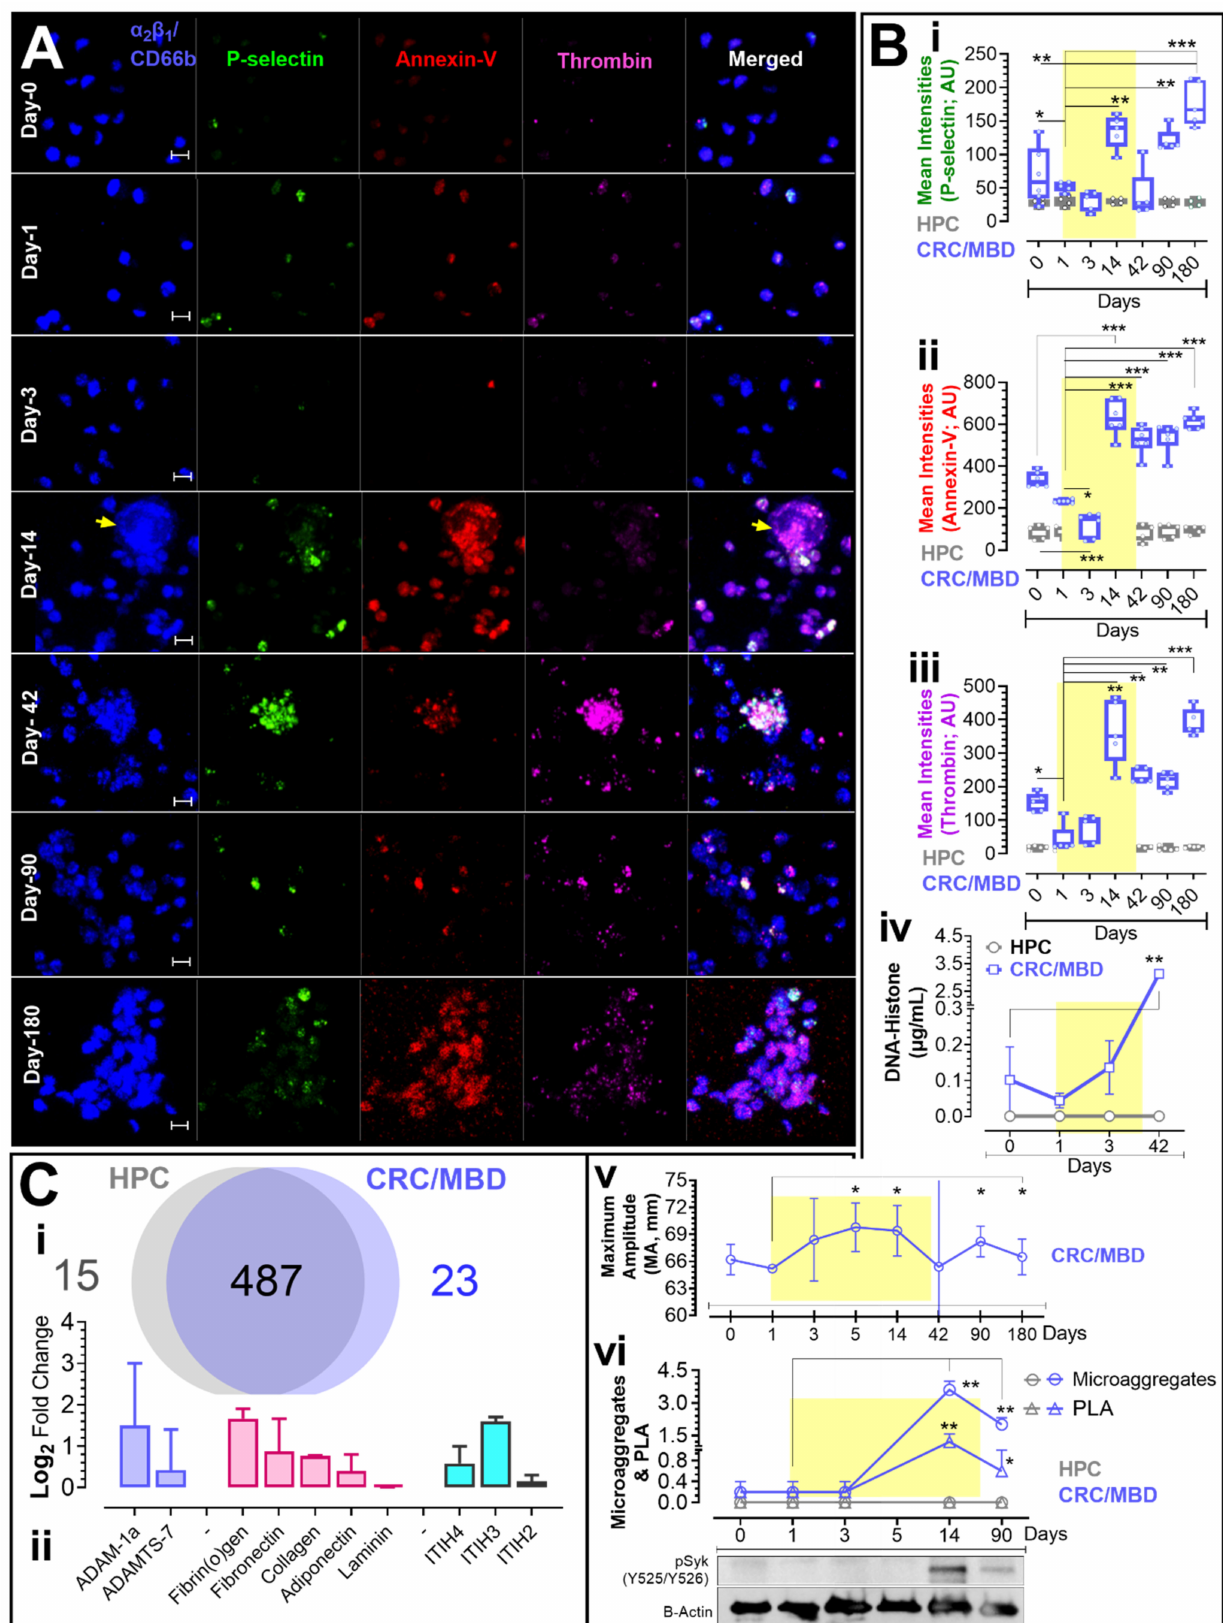
Figure 2. Platelet Procoagulant Membrane Dynamics and Plasma Proteomics Studies in Patients with Metastatic Bone Disease from Primary Colorectal Cancer (CRC/MBD) Before and After